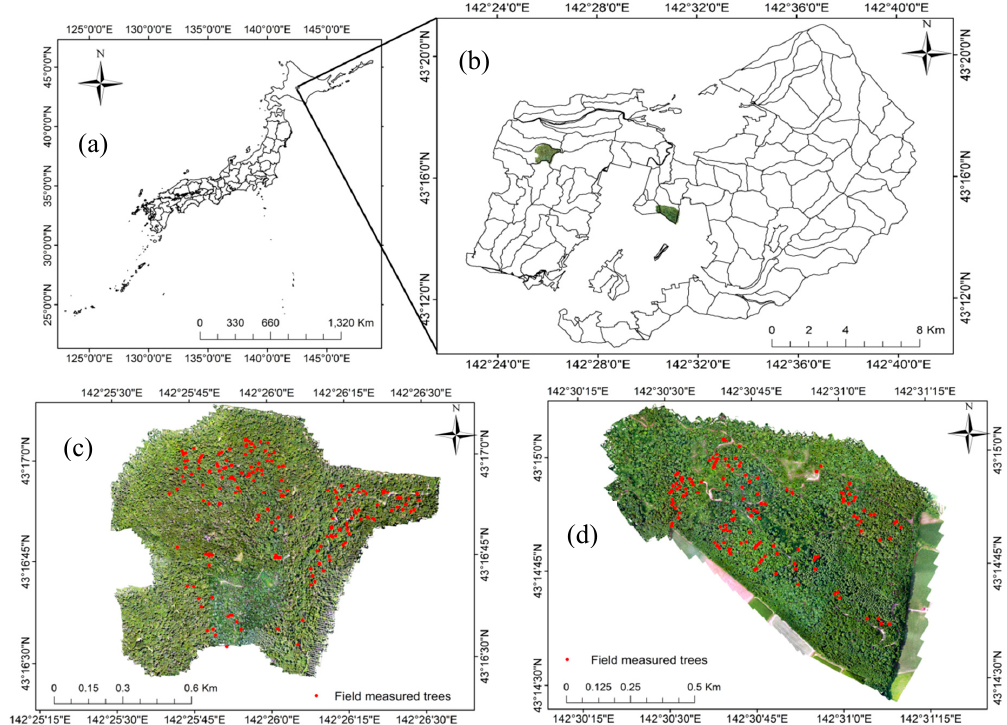
Figure 1. Location of the study area. ( a ) The University of Tokyo Hokkaido Forest, ( b ) Sub-compartment 36 B and 59 A, ( c ) Measured trees at sub-compartment 36B, ( d ) Measured trees at sub-compartment 59A.